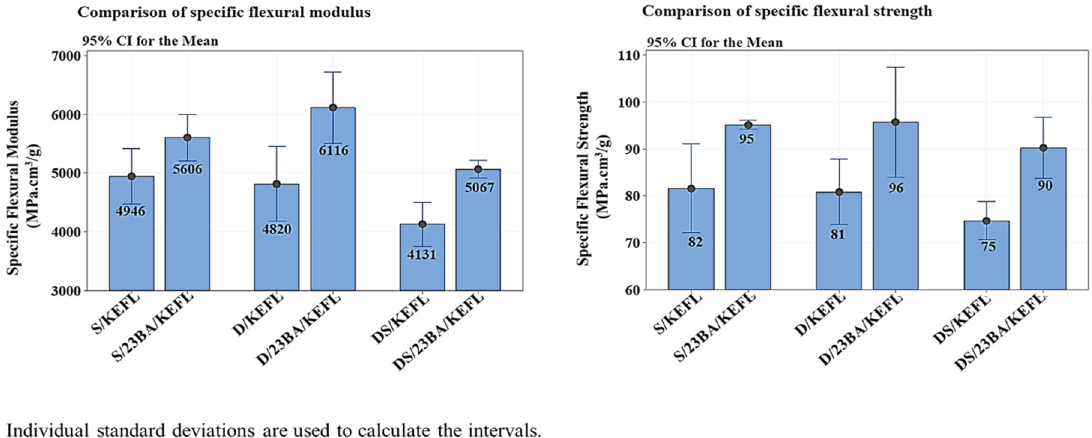
Figure 8. Comparison of specific flexural modulus and strength of composites.